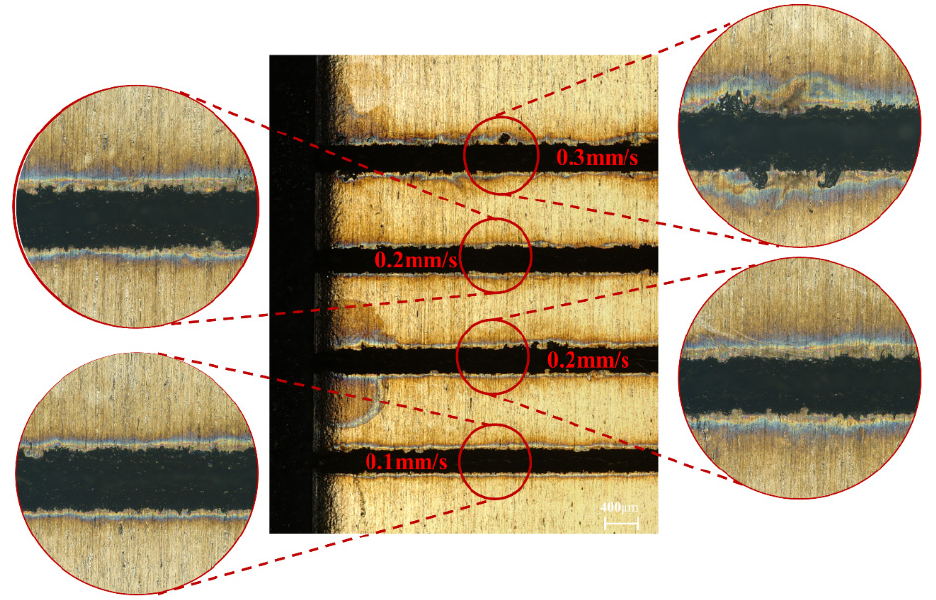
Figure 8. Cut surface morphology at different feed speeds.